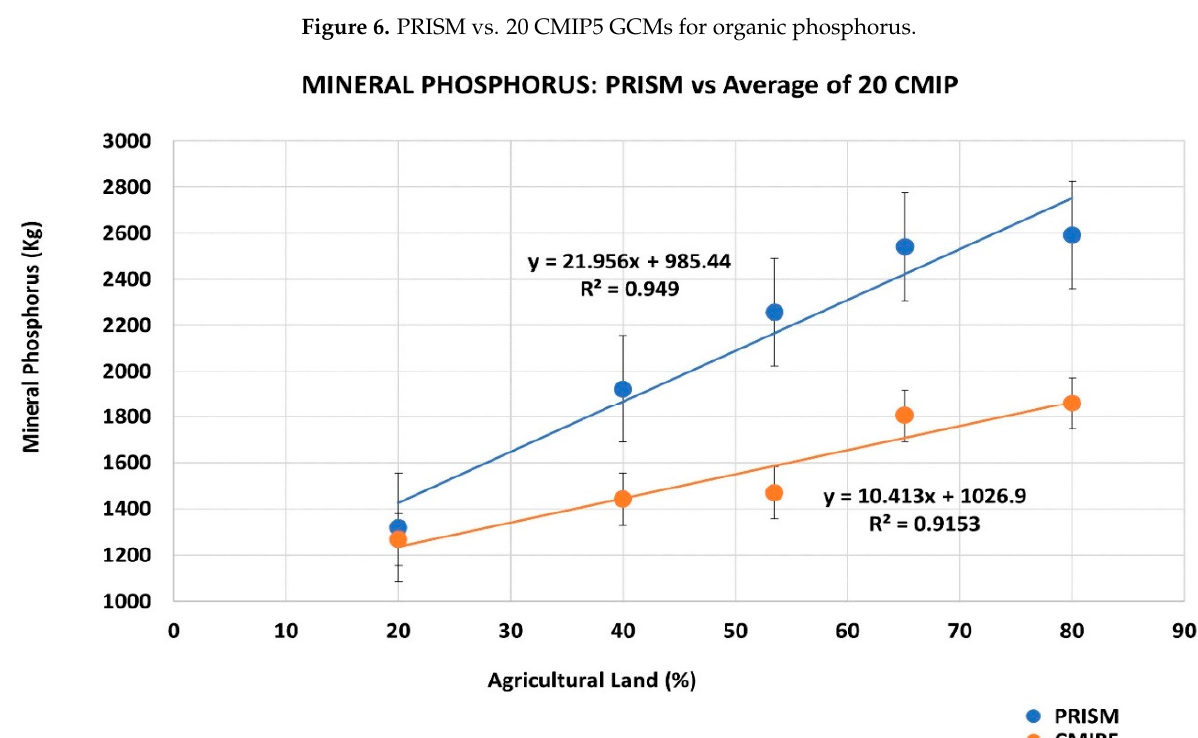
Figure 7. PRISM vs. 20 CMIP5 GCMs for mineral phosphorus.